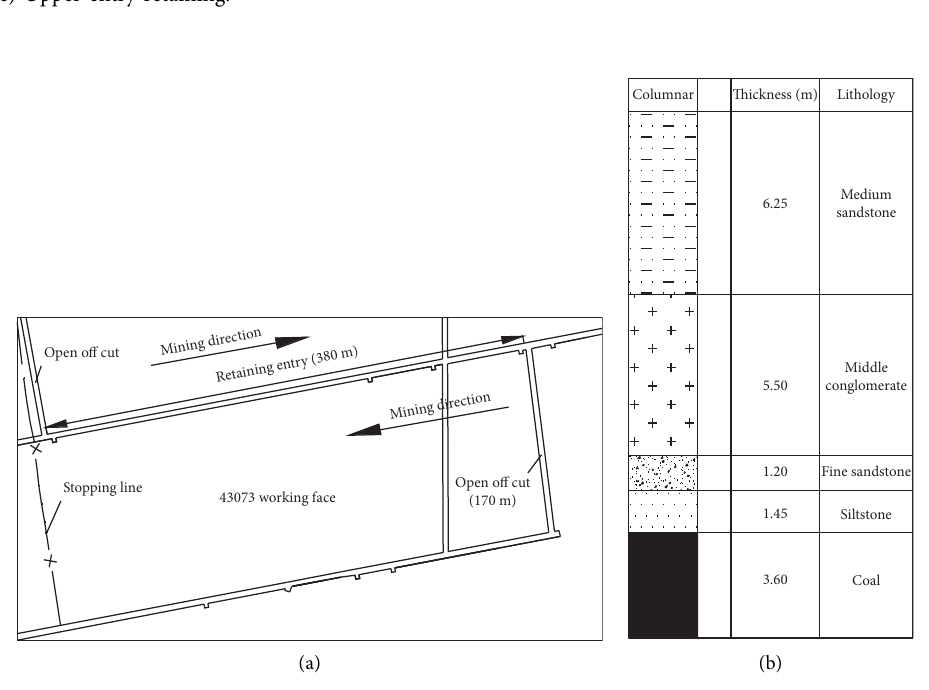
Figure 1: Classification of roof cutting pressure releasing gob-side entry retaining. (a) Entry retaining with near-flat coal seam. (b) Lower entry retaining. (c) Upper entry